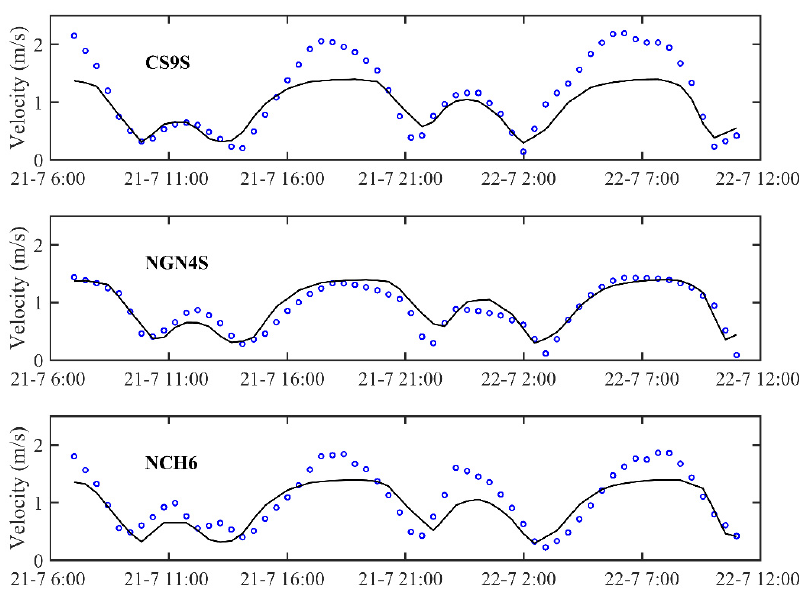
Figure 9. Computed and measured tidal dynamics of the Yangtze estuary and Hangzhou bay.